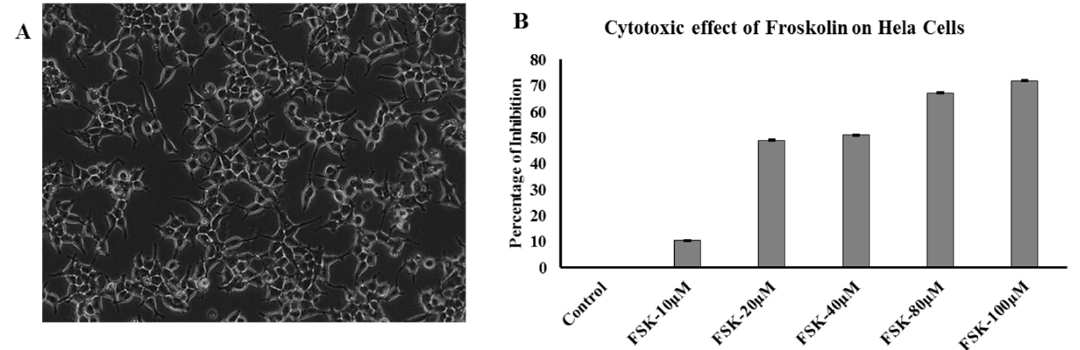
Figure 4. HeLa Cells and Cytotoxicity Assay. ( A ) HeLa Cell Morphology were seen by confocal Microscopy. ( B ) Hela Cells were treated with Forskolin with different concentrations FSK-10µM, FSK-